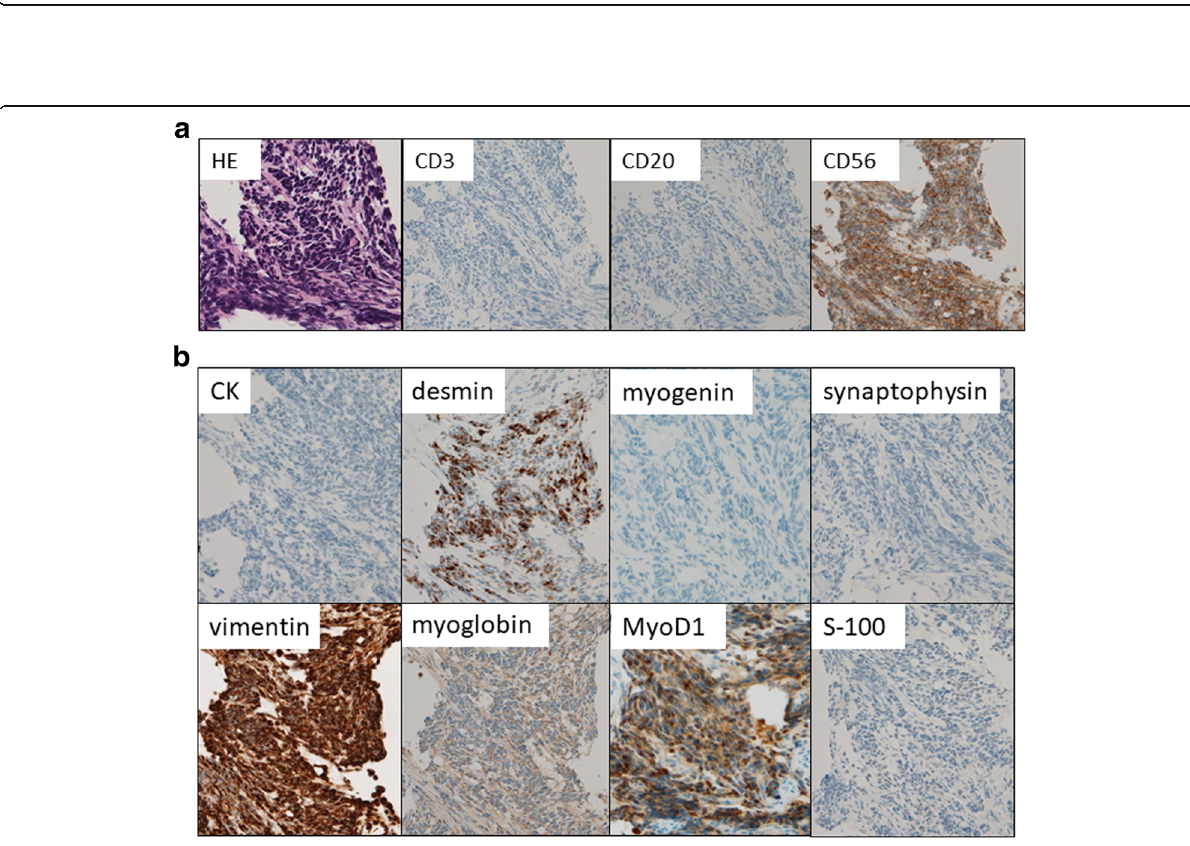
Fig. 4 Pathology of tumor in bone marrow. a Biopsied bone marrow contained small round tumors with dense nuclei diffusely aggregated and focally floating within fibrous nests. Immunohistochemical staining for specific hematological lineages were negative for CD3 and CD20, but positive for CD56. b An additional immunohistochemical study suggested positivity for vimentin. Staining for the muscular differentiation markers desmin, myoglobin, and myogenin were positive, whereas CK and MyoD1 were negative. Staining for the neural differentiation markers synaptophysin and S-100 was negative. Original magnification of 40